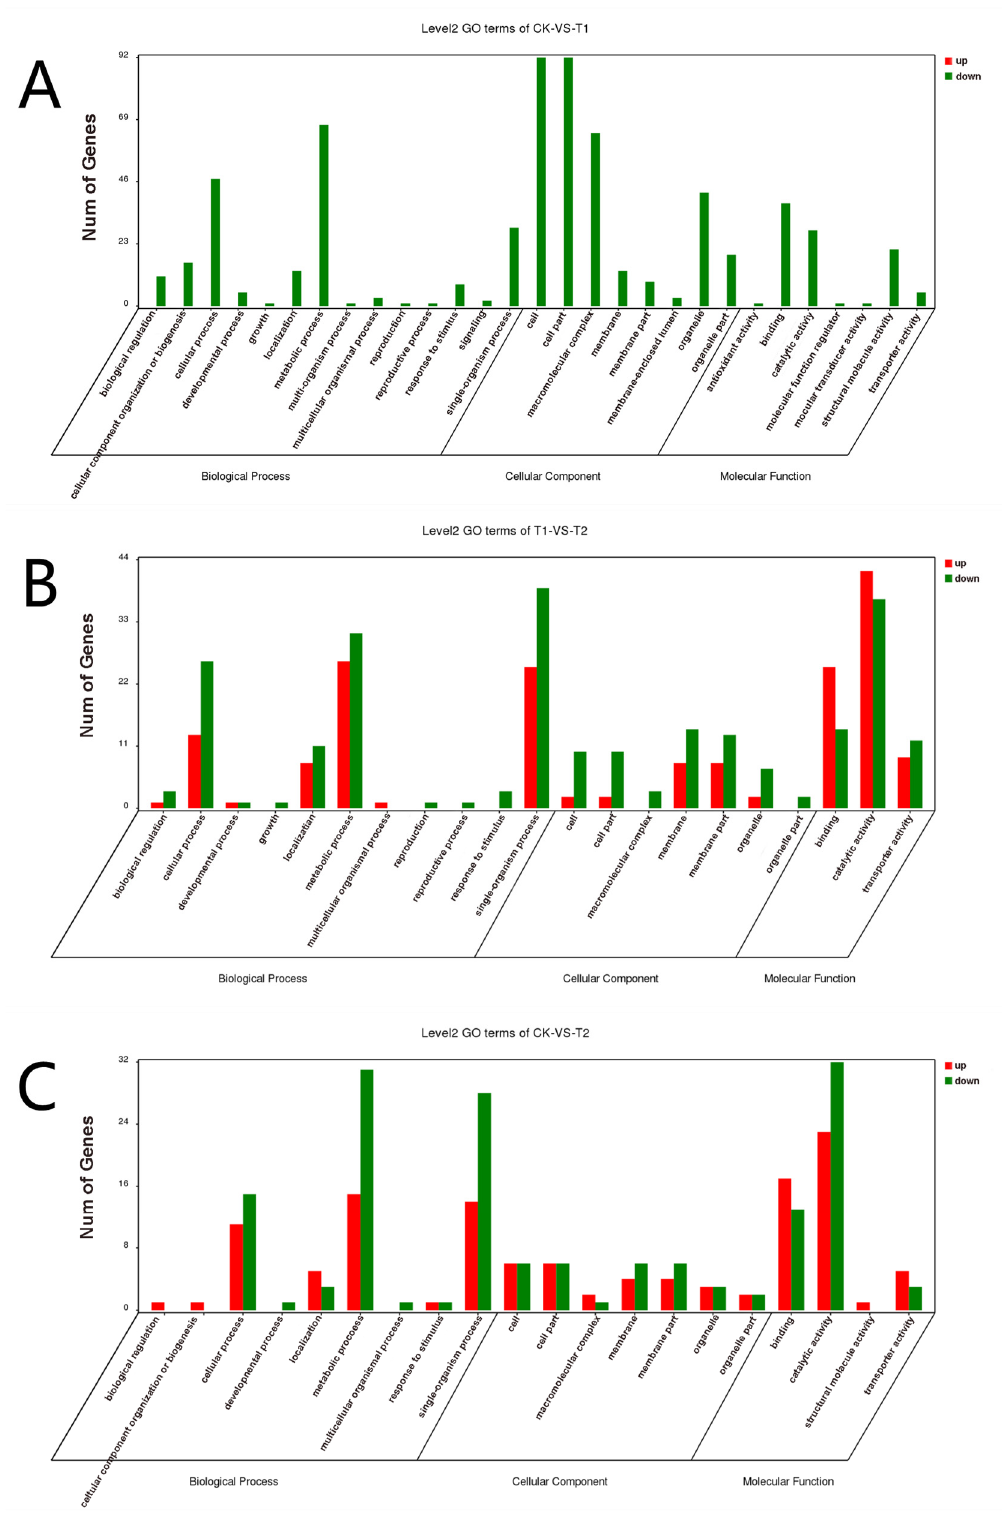
Figure 5. GO classification map of differentially expressed genes under different treatment conditions. ( A ) CK vs. T1; ( B ) CK vs. T2; ( C ) T1 vs. T2. Note: Red represents the up-regulated differentially expressed genes in the GO classification map, and green represents the down-regulated differentially expressed genes in the GO classification map.